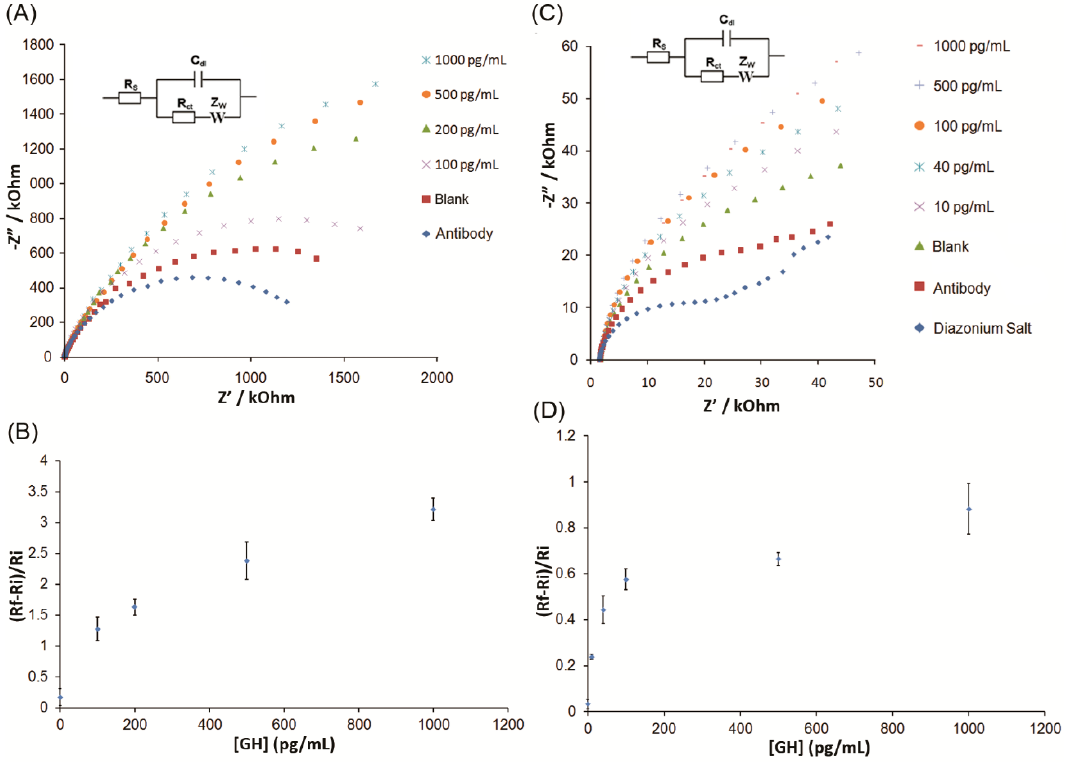
Figure 3. Impedimetric detection of growth hormone (GH) using antibody-modified carbon electrodes; ( A ) Nyquist plots for the detection of various concentrations of GH on glassy carbon electrodes (GCE); ( B ) Dependence of GH concentration on the R ct values obtained from the Randles equivalent circuit at GCE. ( C ) Nyquist plots for the detection of various GH concentrations on screen- printed carbon electrodes (SPCE). ( D ) Dependence of GH concentration on the R ct values obtained